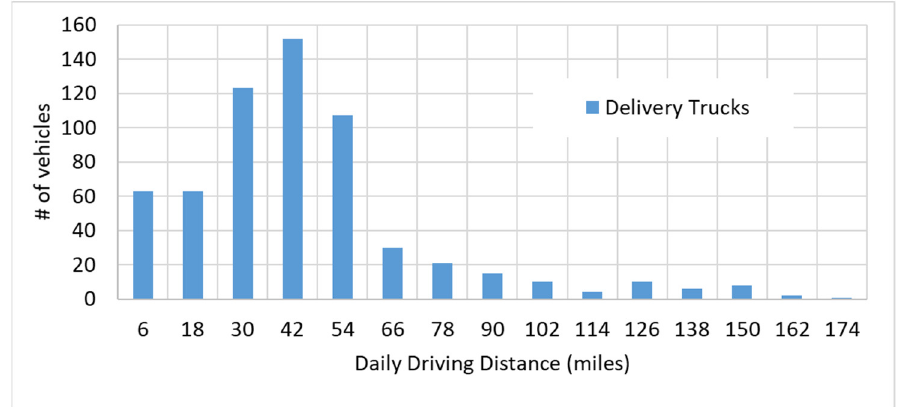
Figure 5. Distribution of daily trip distance for delivery trucks from FleetDNA.